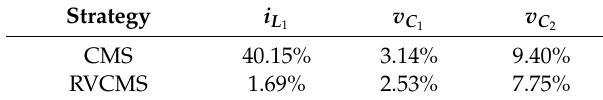
Table 2. The 2 ω ripple ratios with a di ff erent modulation strategy.